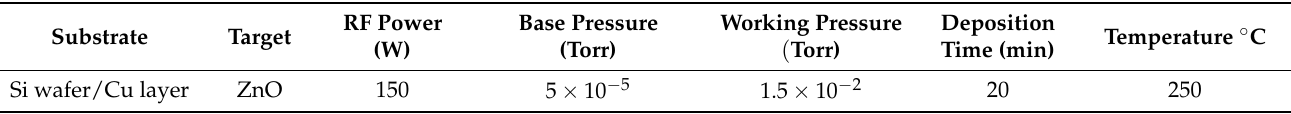
Table 2. Details of the ZnO film deposition conditions.